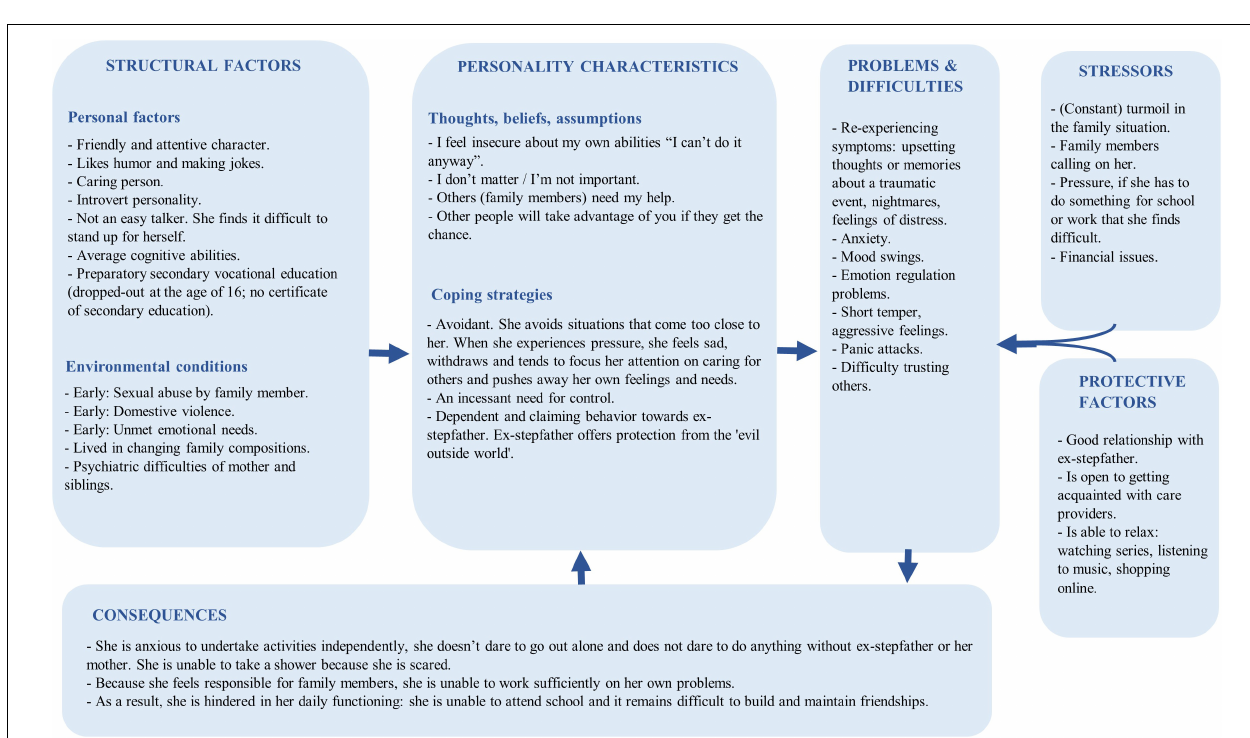
FIGURE 2 | Holistic problem analysis (based on a holistic model from the Dutch Association for Behavioural and Cognitive Therapies).